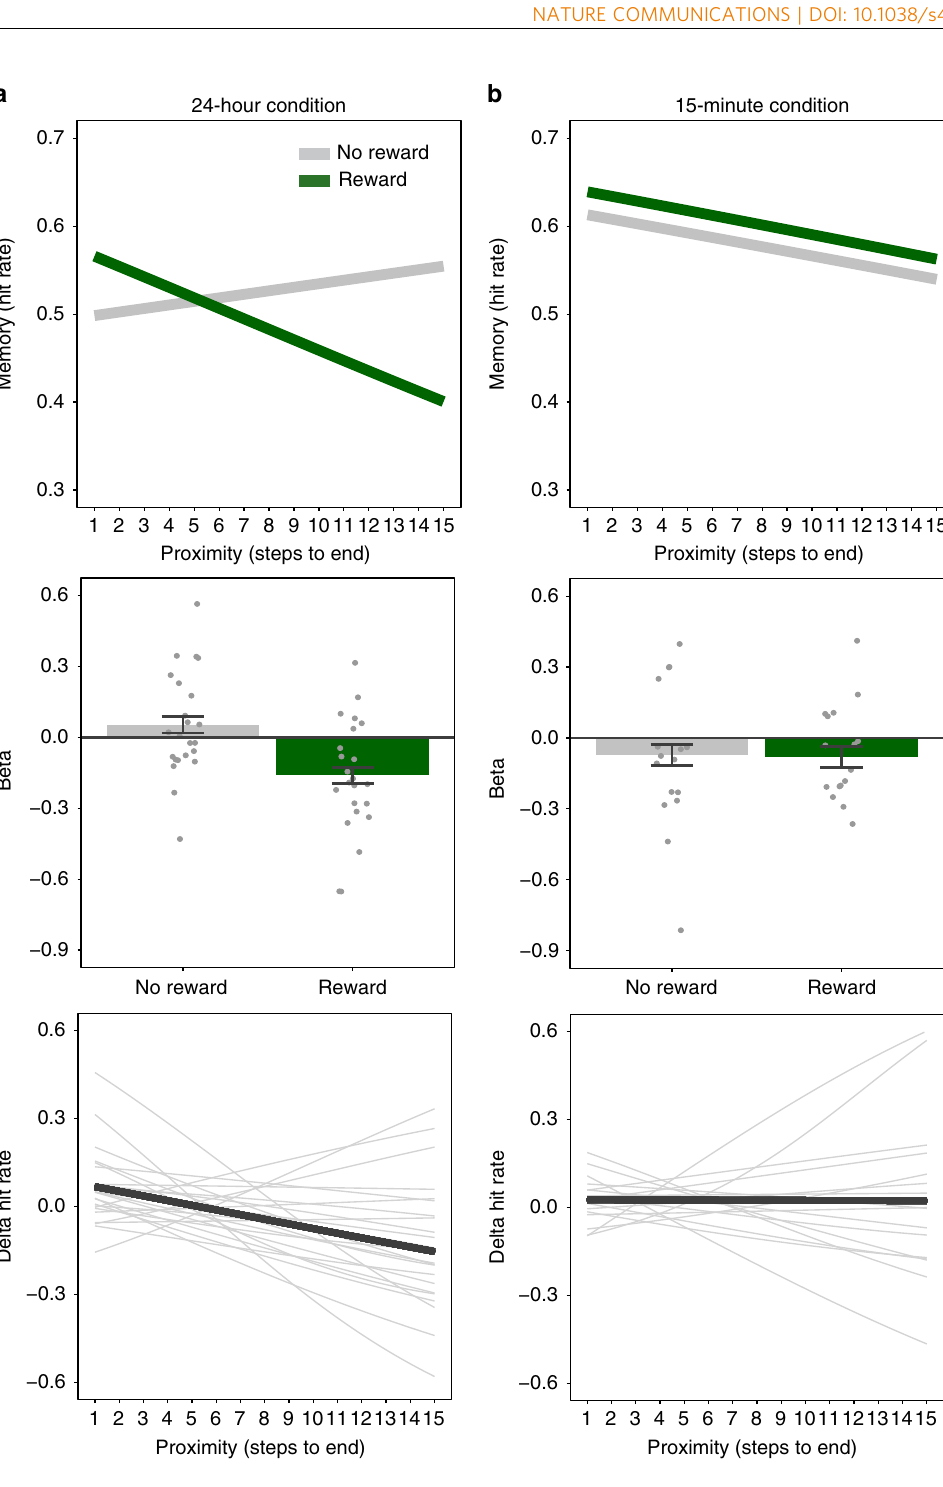
of the maze outcome: either a high reward (a gold coin worth $1) or low reward (a dime worth $0.10) was always presented in a maze square. When controlling for the location of the maze outcome, we again found the reward proximity effect (multi-level logistic regression; Experiment 3 ( n = 32): reward × proximity: β = [ − 0.17, − 0.071], p < 0.0004; proxi- = − 0.12, SE = 0.027, CI 95 mity: reward (gold coin) mazes: β = − 0.16, SE = 0.038, z = = [ − 0.24, − 0.085], p < 0.0004; low reward (dime) − 4.15, CI 95 mazes: β = 0.082, SE = 0.038, z = 2.17, CI 95 = [0.0084, 0.16], p = 0.030; see Supplementary Figure 1c and Supplementary Figure